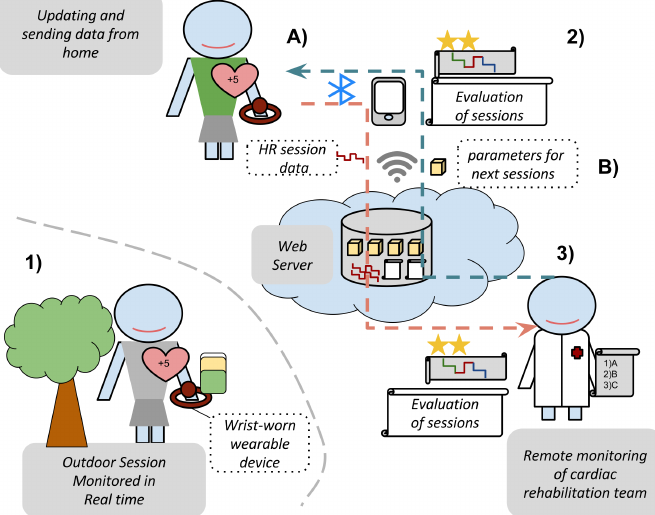
Figure 3. Architecture of components: ( 1 ) wearable device with real-time monitoring; ( 2 ) mobile application for evaluating the sessions; and ( 3 ) a web platform for evaluating the sessions by the cardiac rehabilitation team. The data from the patient and the team are synchronized ( A ) from wearable to mobile by Bluetooth; and ( B ) from mobile to cloud services by